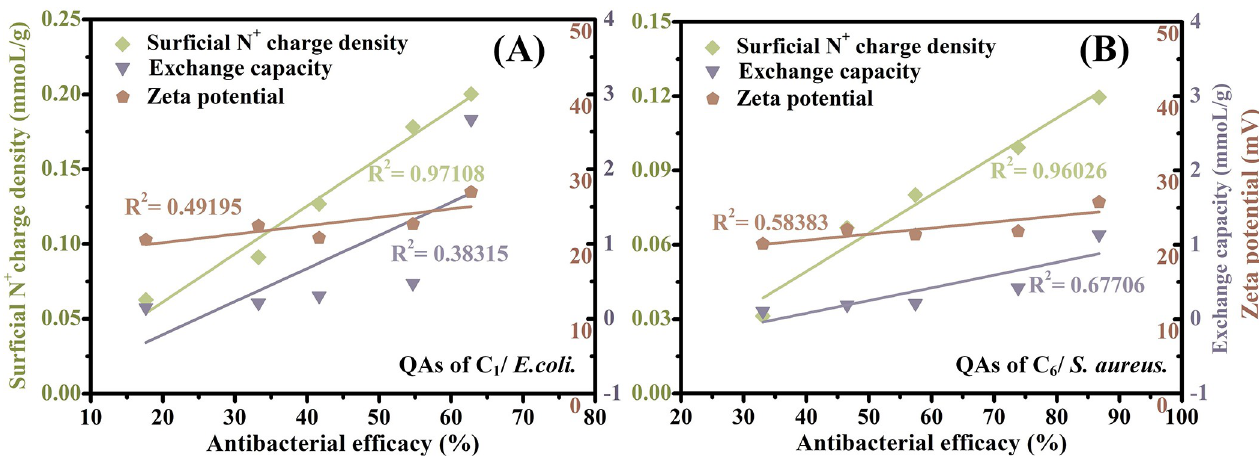
Fig 3. (A) Correlation analysis of antibacterial efficacy with surficial N + charge density, exchange capacity and zeta potential of Py-1C resin; (B) correlation analysis of antibacterial efficacy with surficial N + charge density, exchange capacity and zeta potential of Py-6C resin. QAs: quaternary ammonium groups; “QAs of C 1 / E . coli ”: QAs with methyl against E . coli ; “QAs of C 6 / S . aureus ”: QAs with hexyl against S . aureus . All experiments were performed at least in